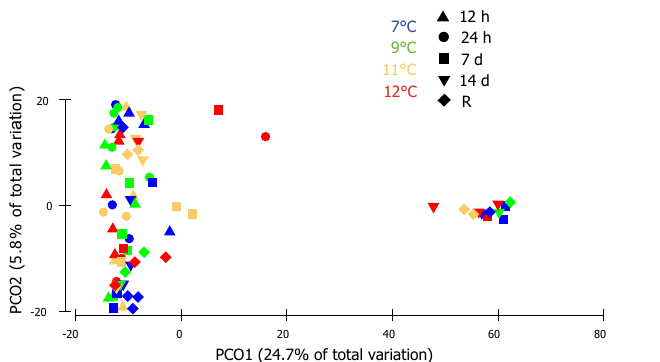
Figure 6. Principal coordinate analysis (PCO) of the bacterial OTUs from G. barretti explants exposed to four different temperature levels (see attached legend) over a 14 d experimental period. R on the legend represents 65 d post exposure (the recovery period), with explants being maintained at ambient temperatures (7 °C) after the 14 d experimental period, irrespective of prior temperature